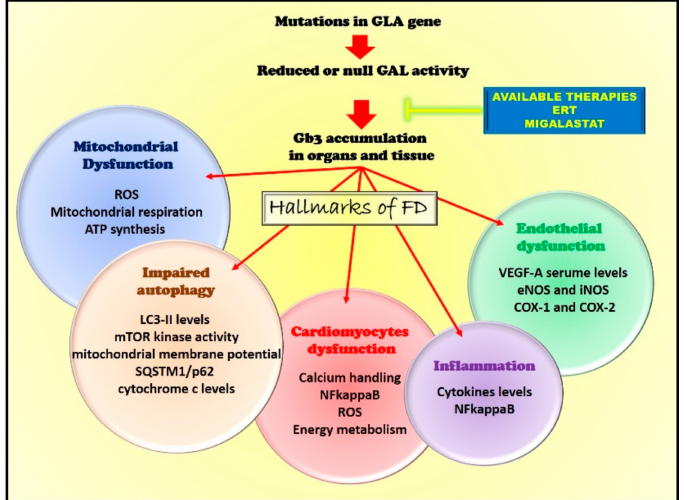
Figure 3. The hallmarks of FD. Mutations in GLA impairs alpha-galactosidase A (GAL) activity leading to Gb3 accumulations in organs and tissues. This causes several cellular alterations leading to the development of the key pathologic features of Fabry disease (endothelial dysfunction, inflamma- tion, cardiac dysfunction, and alterations of autophagy and mitochondrial function). The available therapies, enzymatic replacement therapy (ERT) and Migalastat, target GAL activity to restore the enzyme’s optimal levels and